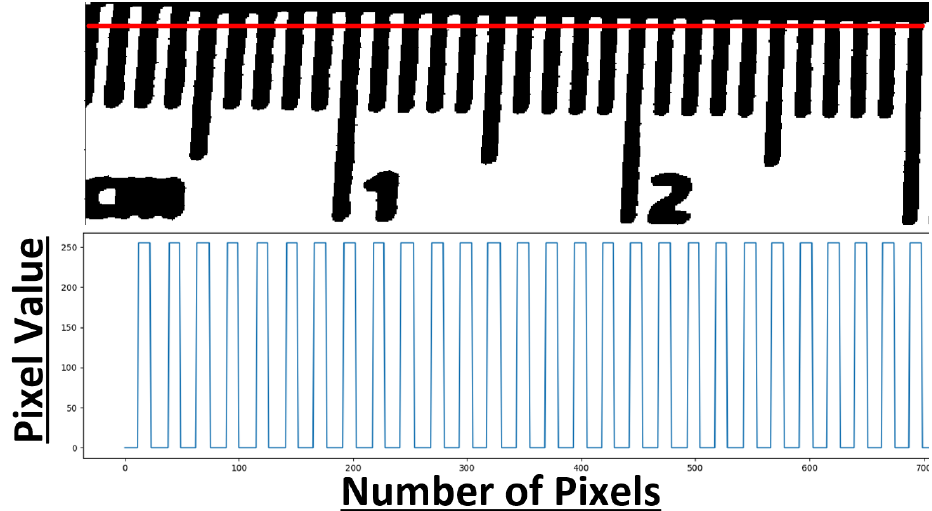
Figure 4. (Final Spatial Frequency) On top is the line used to measure M f . Below is the line graduation distribution in